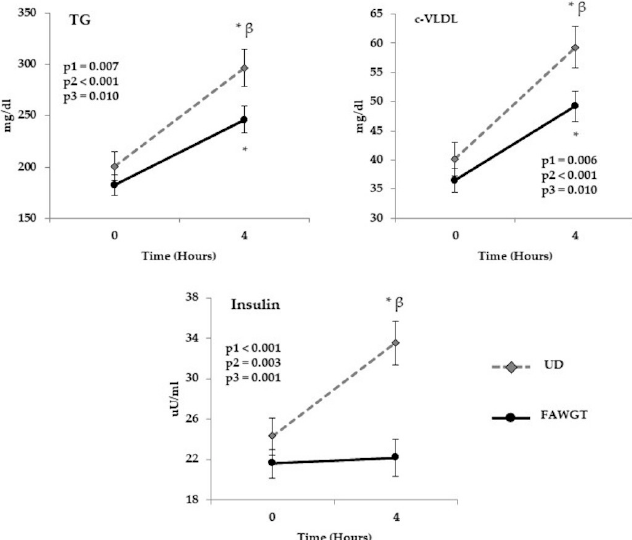
Figure 3. Chronic postprandial effect of dietary intervention. Results correspond to the postprandial study performed on the last day of each dietary period. Values are shown as mean ± S.E.M, and the analysis corresponds to an ANOVA of repeated measurements, where p1 = diet influence; p2 = time, kinetics after 4 h; and p3 = the interaction of the two factors (diet vs. time). * p < 0.05 = 4 h after breakfast compared to fasting. β = p < 0.05 FAWGT vs. UD. FAWGT: diet based on fruit, avocado, whole grains, and trout; UD: usual diet.; TG: triglycerides; VLDL-c; very low-density lipoproteins.